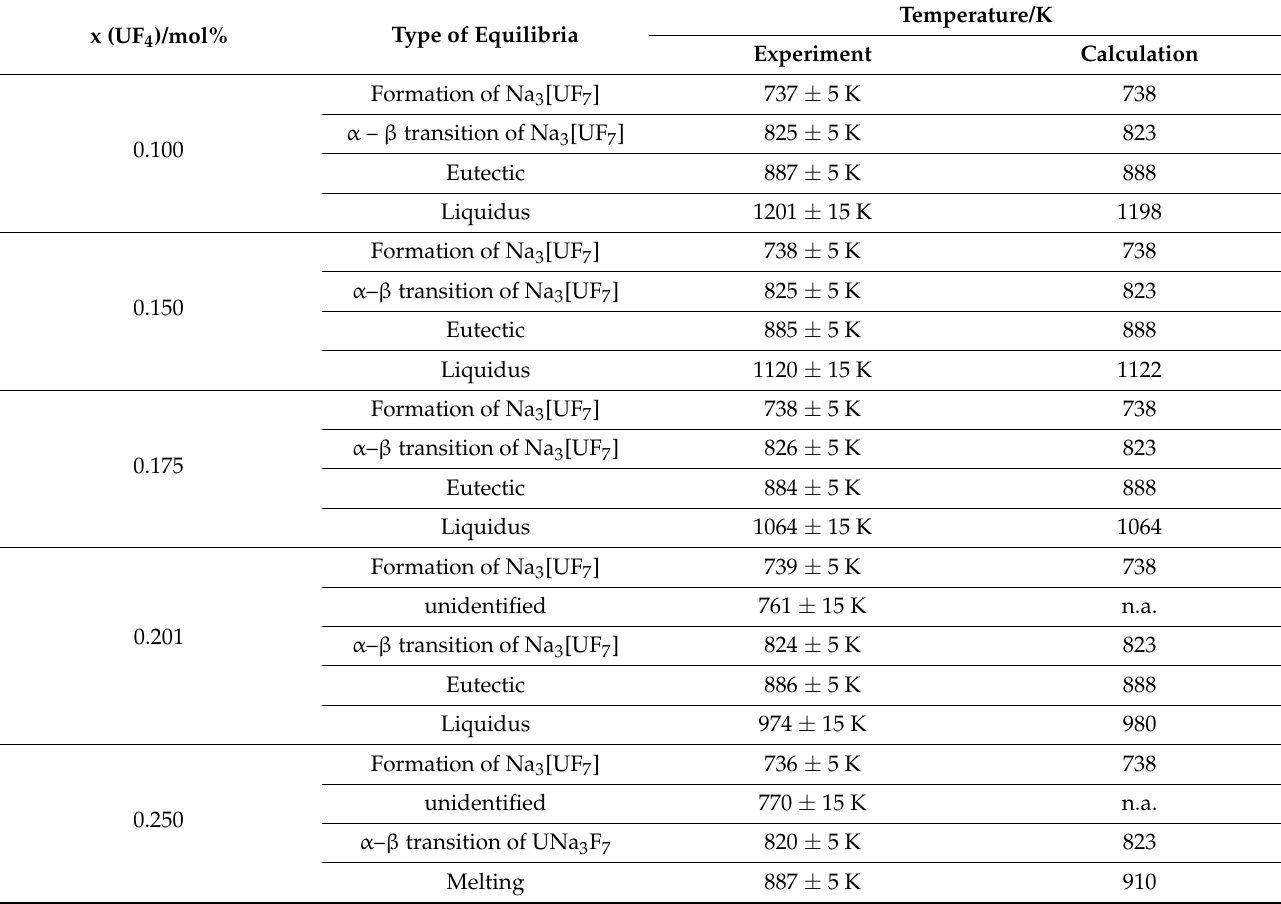
Table 3. Experimental phase equilibria and temperatures obtained by DSC for the NaF-UF 4 system and the calculated transition temperatures at these compositions for